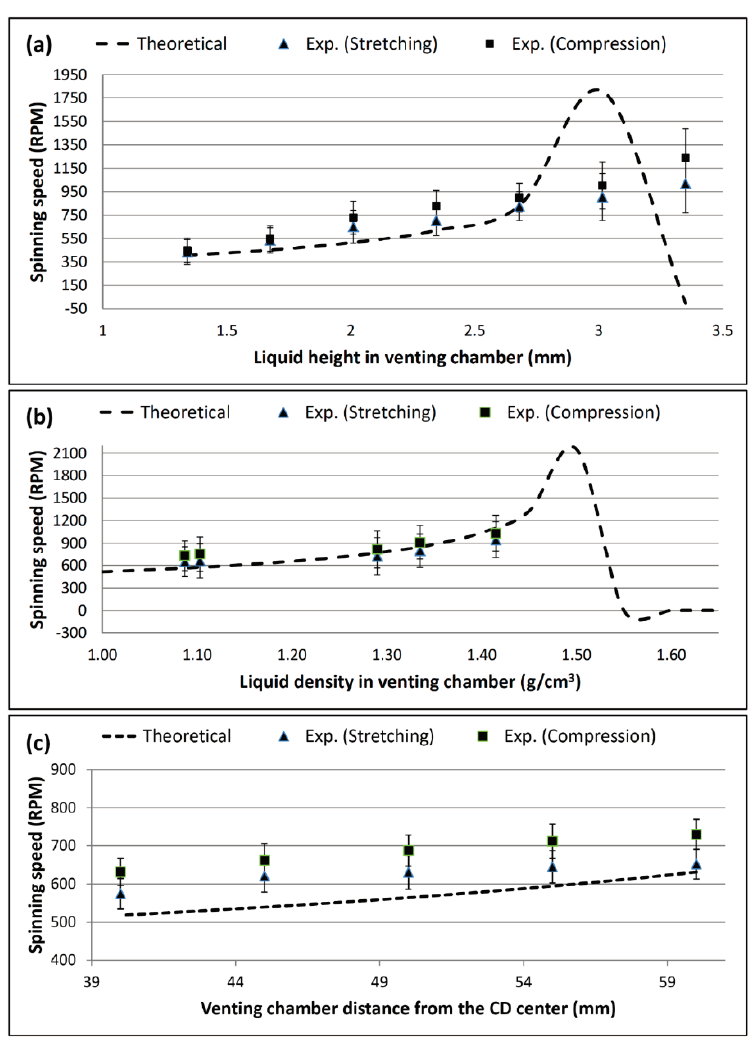
Figure 5. Theoretical and experimental results for ( a ) the effect of different venting chamber liquid heights on burst frequency, ( b ) the effect of different venting chamber liquid densities on burst frequency, and ( c ) effect of different venting chamber positions on burst frequency (theoretical result calculated using Equation